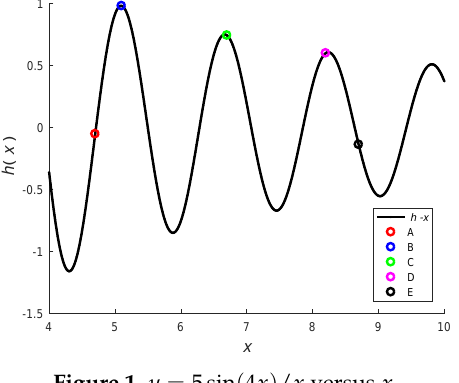
Figure 1. y = 5sin ( 4 x ) / x versus x